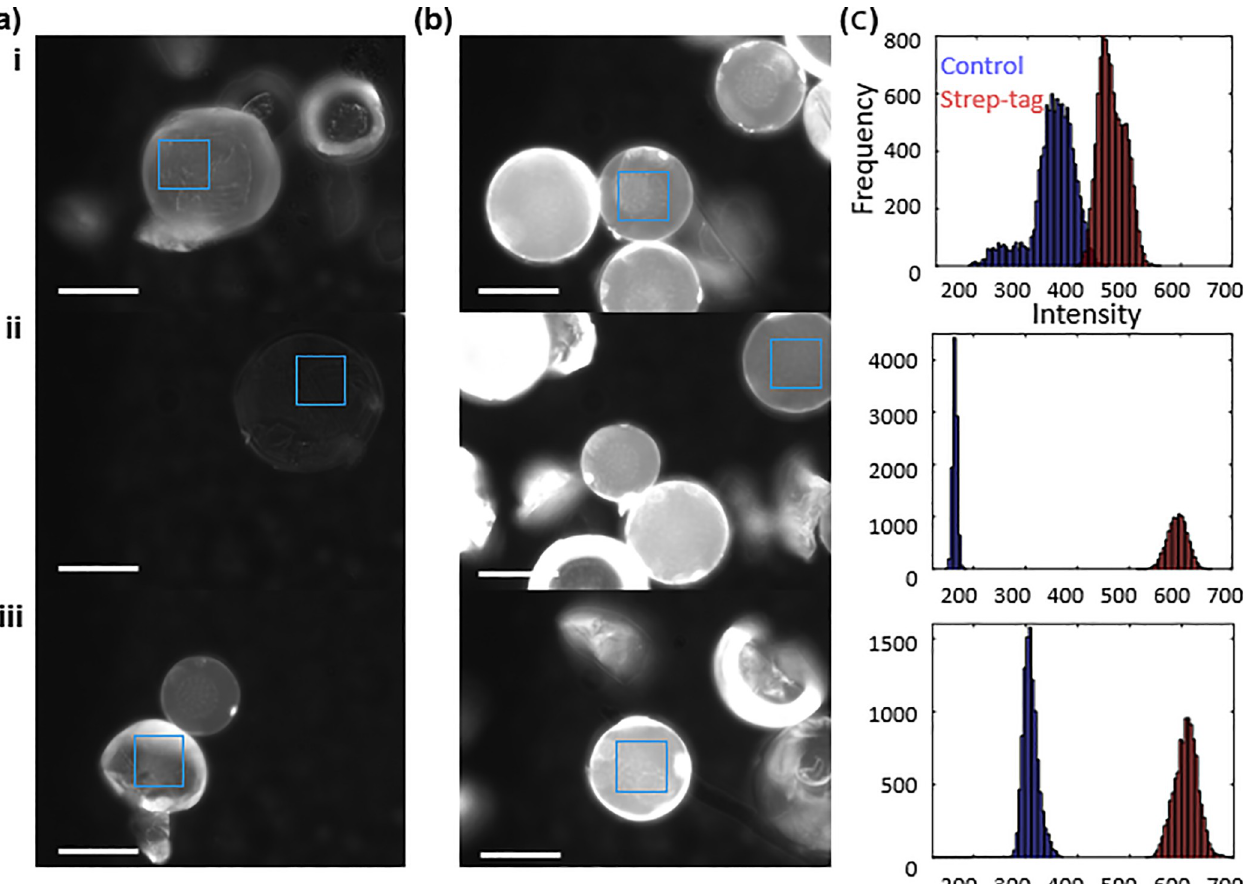
Fig 3. Fluorescent microscope image of aminomethyl styrene resin functionalized with (a) control (GS) 4 sequence and (b) strep-tag after incubated with FITC-streptavidin. (c) Histogram comparison of pixel intensities collected from regions of interest (solid blue boxes in a-b). (i-iii) Replicates. Scale bars are 50 μ